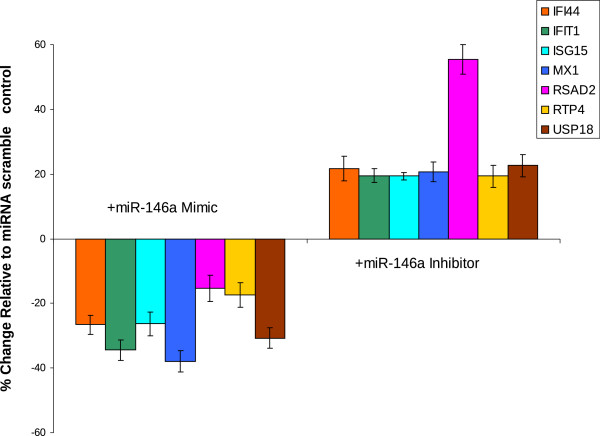
miR-146a alters the expression of type 1 IFN inducible genes in C2C12 muscle cells. C2C12 cells were transfected with miR-146a mimics and miR-146a inhibitors, as well as the appropriate scrambled controls. 24 hours after transfection, cells were stimulated with mouse IFN-alpha for 4 hours before RNA was isolated and profiled for alterations in ISGs. Regulation of the IFN pathway was demonstrated by increased ISG transcript levels following inhibition of miR-146a, as well as decreased ISG transcript levels following addition of miR-146a. Values are shown as mean ± SEM and represent results from 3 independent experiments.